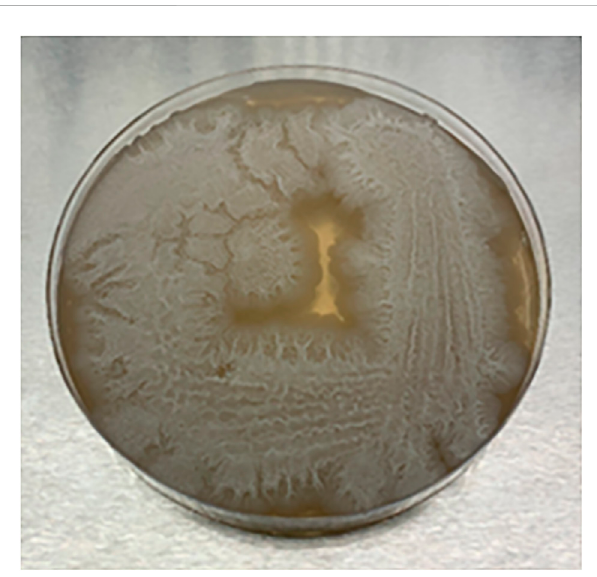
FIGURE 11 Colony morphology of unknown microbial growth isolated from pasteurized corn-DDGS